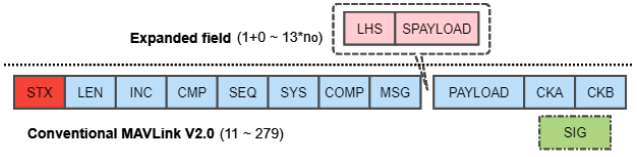
Figure 3. E-MAVLink